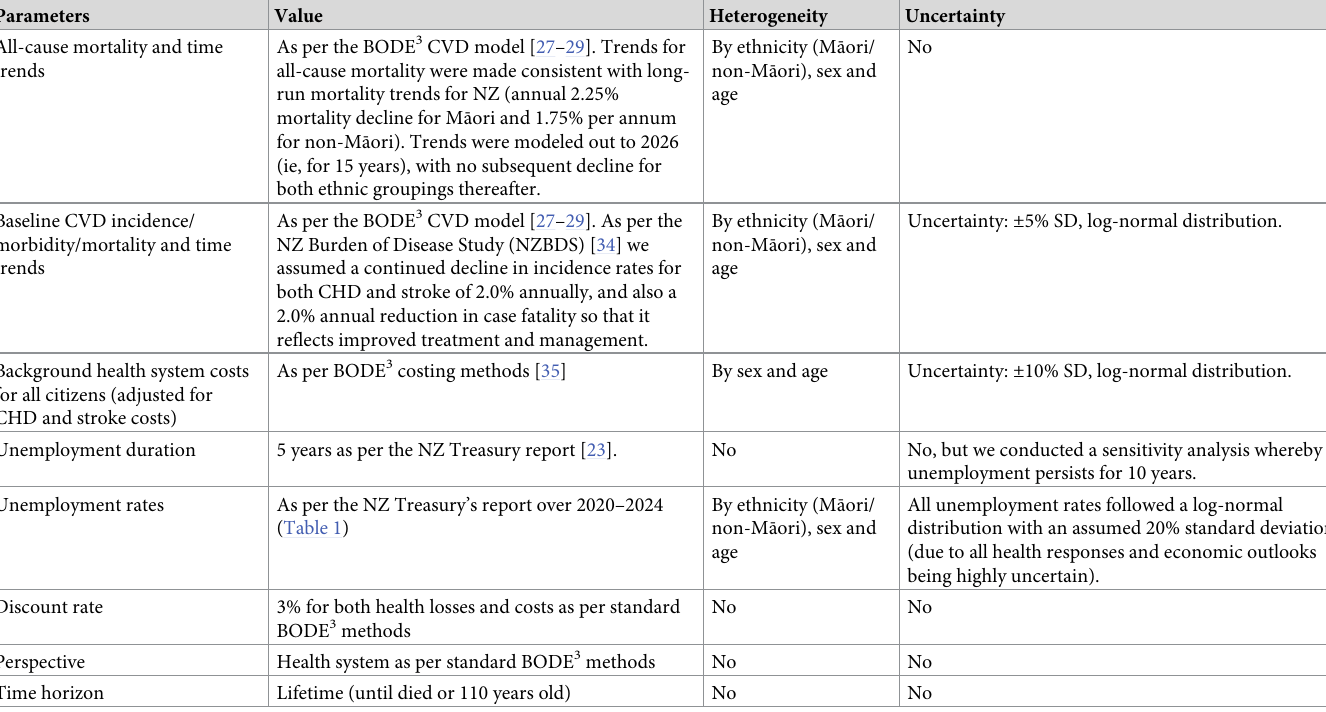
Table 3. Key epidemiology and economic parameters for the established BODE 3 CVD model [27–29].